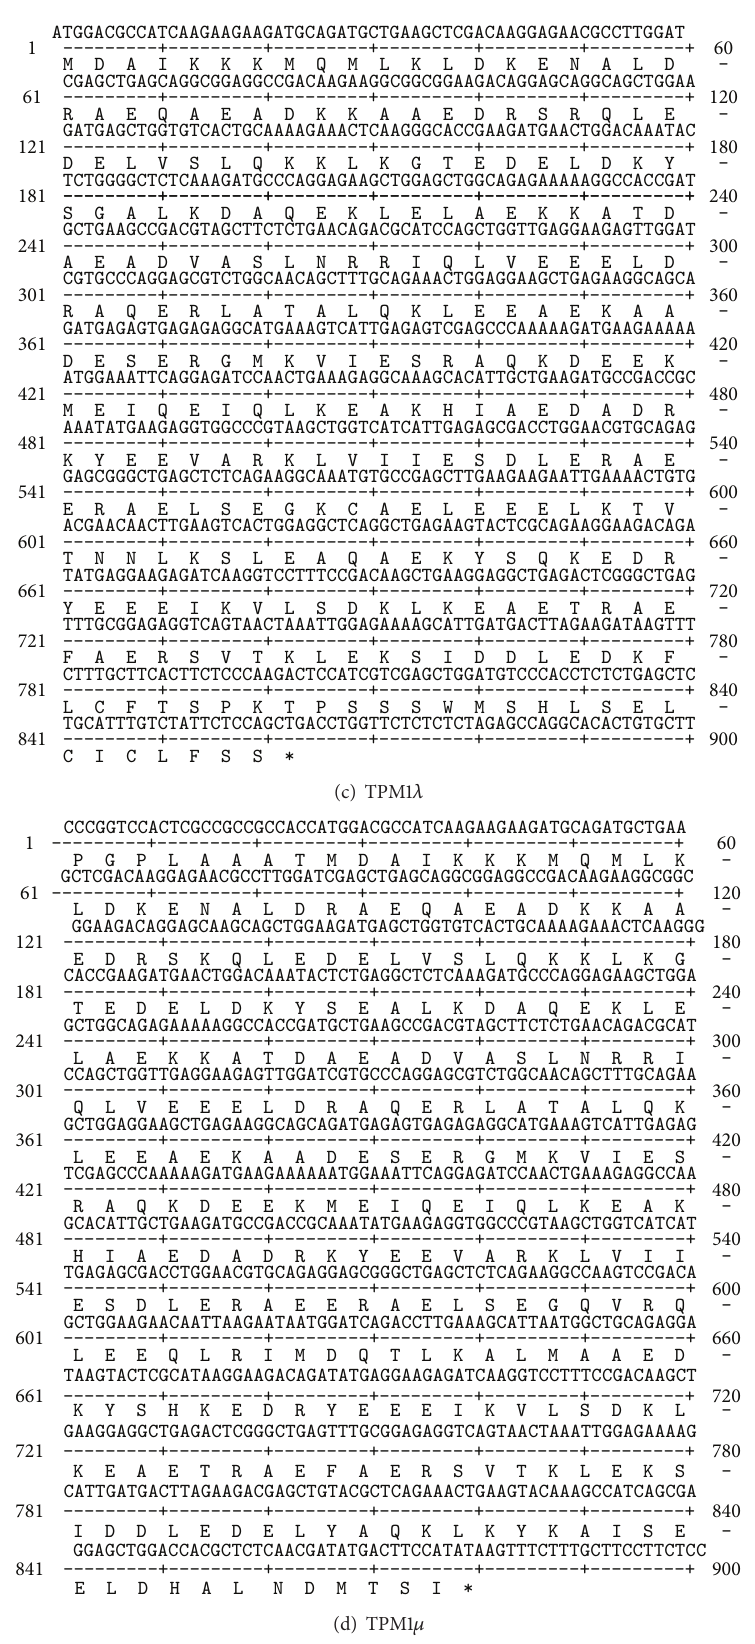
Figure 3: cDNA sequences (upper line) and amino acid translations (lower line) of TPM1 𝜆 – 𝜀 . The symbol ∗ represents a stop